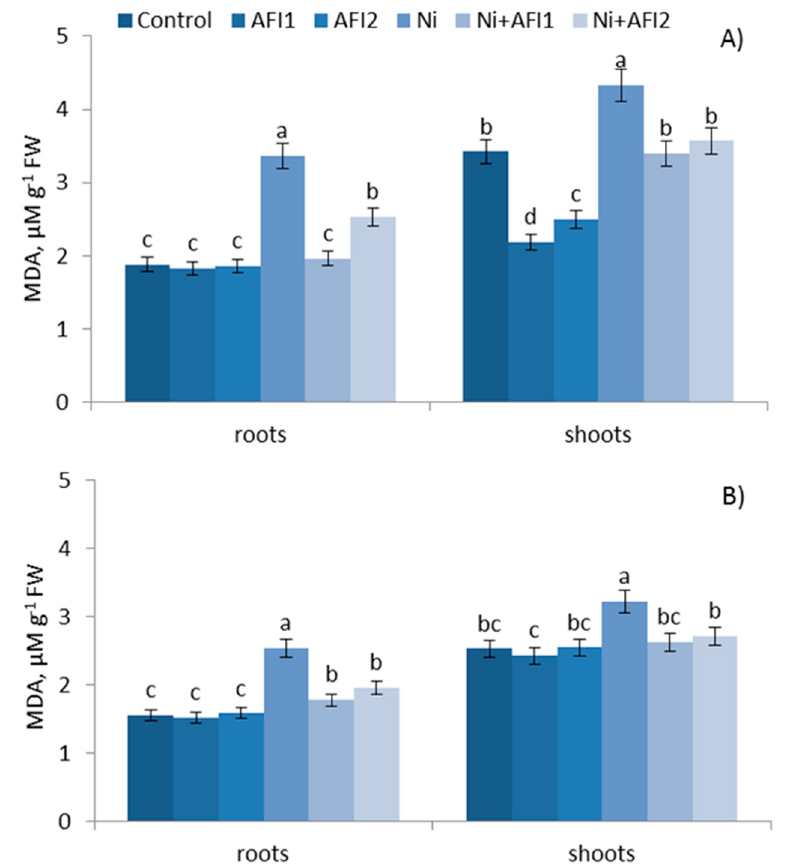
Figure 5. Effect of PGPB on LPO activity in wheats: ( A ) Chinese spring S, ( B ) Leningradskaya 6 T. Different letters indicate a significant difference between the means at the probability level of p < 0.05, as determined by Duncan’s multiple range test.